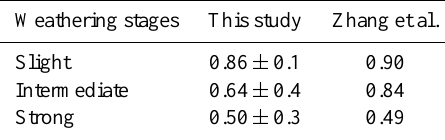
Table 4. Comparison of our estimated total soil P (mean ± sd) for China with Zhang et al. (2005) (unit: kgPm − 3 )